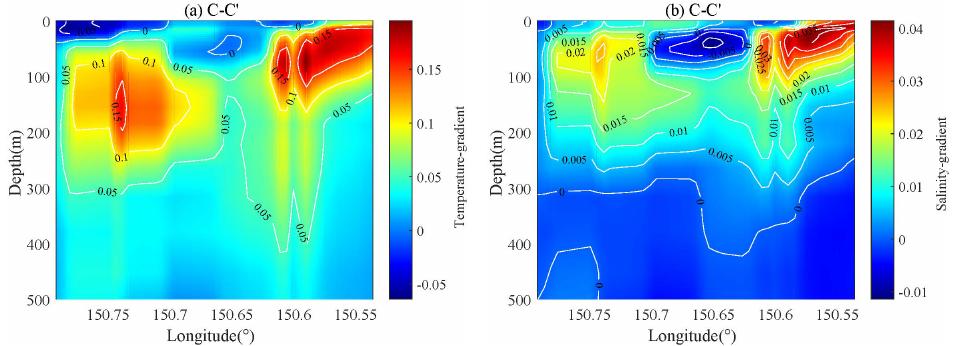
Figure 9. Distributions of temperature ( a ) and salinity ( b ) gradients.